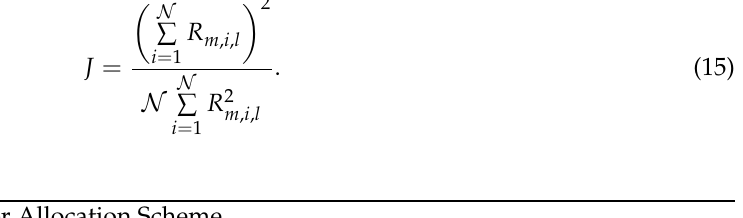
Algorithm 1 Auction-based Power Allocation